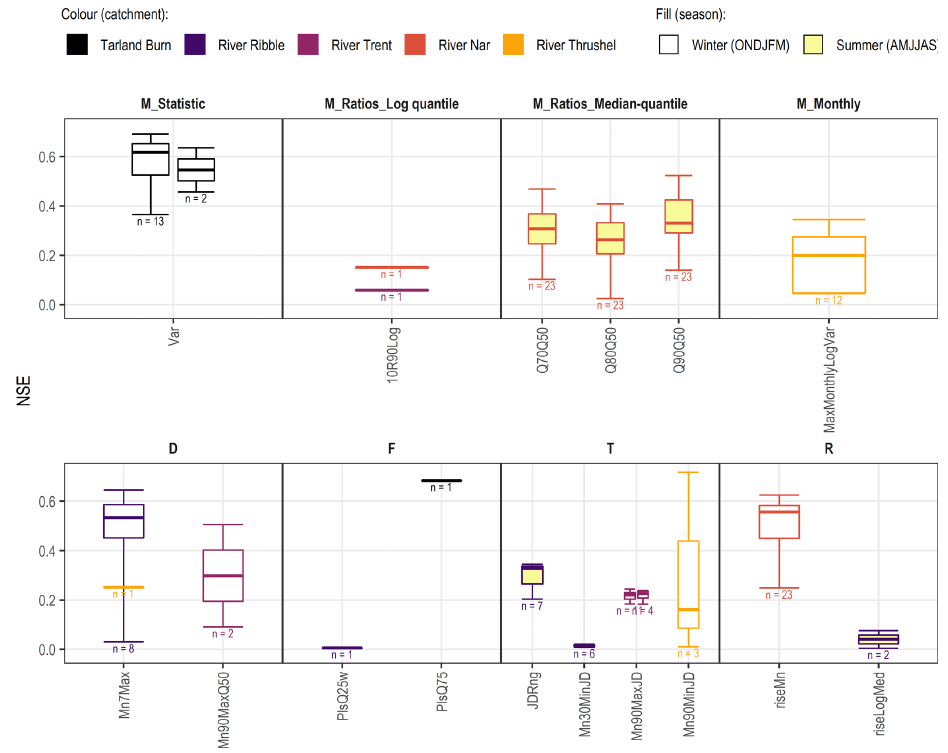
Figure 5. Nash–Sutcliffe efficiency (NSE) for each ER HI where NSE > 0 (model skill greater than the observational mean); see Fig. B2 for all NSEs. The ER HIs are grouped by facet of the flow regime: magnitude ( M ), duration ( D ), frequency ( F ), timing ( T ) and rate of change ( R ). The four- and five-parameter results are adjacent, left and right respectively, for the Tarland Burn and River